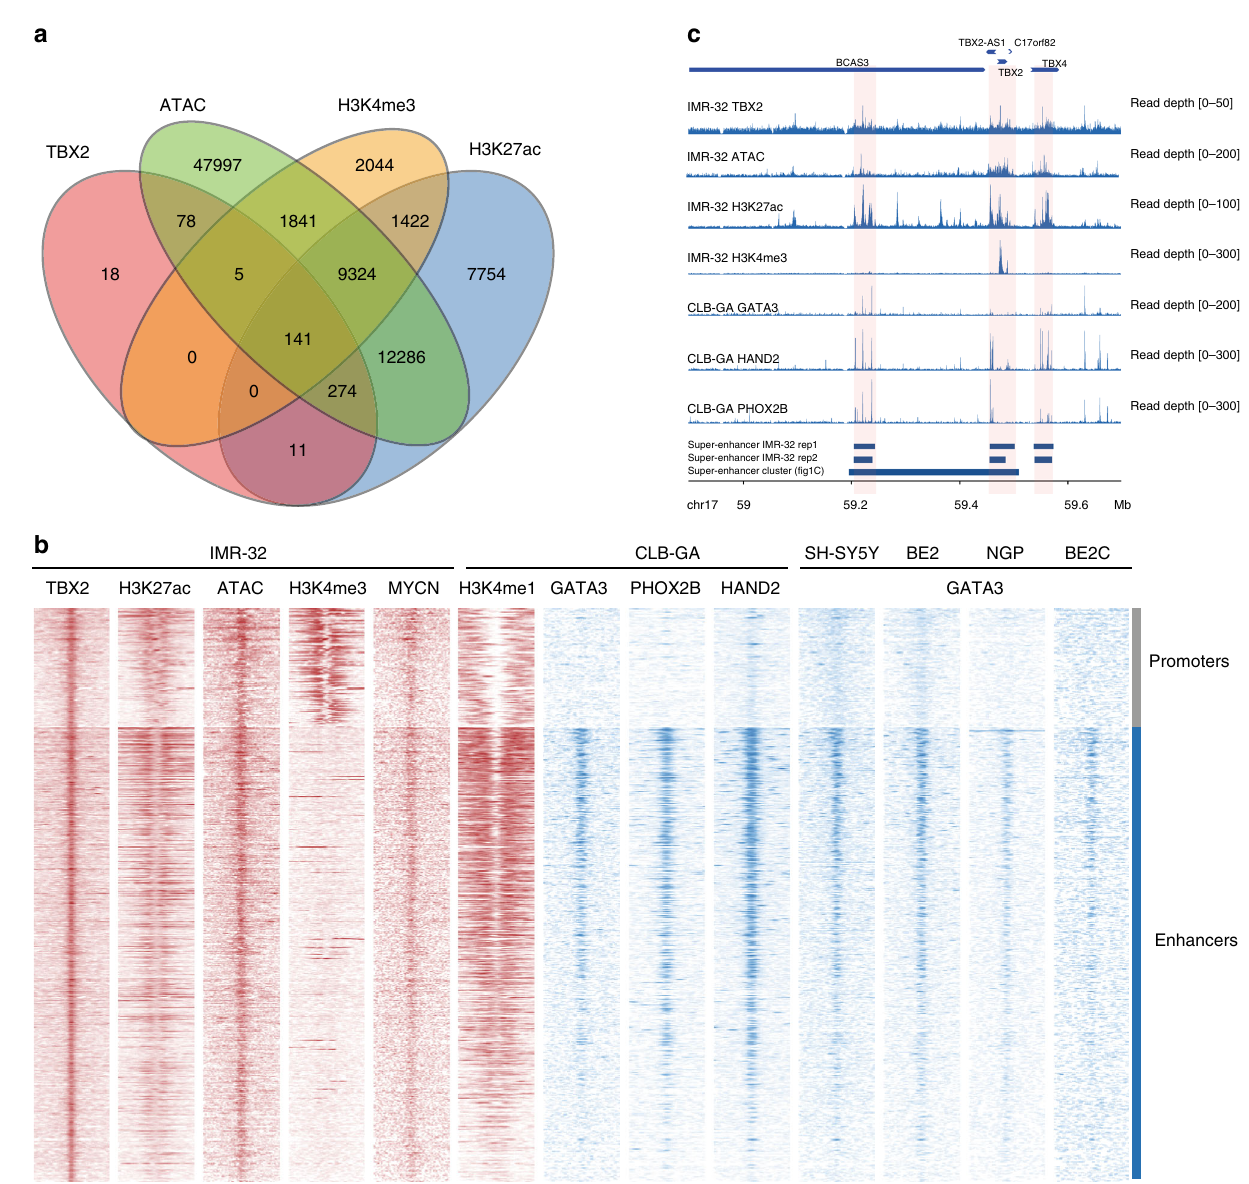
Fig. 3 TBX2 is part of a core-regulatory circuitry. a Signi fi cant (Fisher test p -value < 2.2e − 16) overlap (min. overlap = 20 bp) of the TBX2 (qval < 0.05), H3K27ac (qval < 0.05), H3K4me3 (qval < 0.05) ChIP-seq and ATAC (qval < 10^ − 6) peaks in the IMR-32 cell line. b Heatmap pro fi les − 4 kb and + 4 kb around the summit of TBX2 peaks. The heatmaps represent the ChIP-seq overlap of TBX2, H3K27ac, ATAC, H3K4me3, and MYCN peaks in the IMR-32 cell line, the histone mark H3K4me1 and the CRC genes GATA3 , PHOX2B , and HAND2 in the CLB-GA cell line, and GATA3 in the SH-SY5Y, BE2, NGP, and BE2C cell lines, grouped for promoters or enhancers (homer annotation), and ranked according to the sums of the ChIP-seq peak scores across all ChIP- seq peaks in the heatmap. c TBX2 region (59.1Mb – 59.65 Mb) with the TBX2, ATAC, H3K27ac, and H3K4me3 ChIP pro fi les in IMR-32 and GATA3, HAND2 and PHOX2B ChIP pro fi les in CLB-GA. At the bottom, the Lilly called SEs are annotated for the two replicates in IMR-32 as well as the cluster of SEs used for the prioritization (Fig.